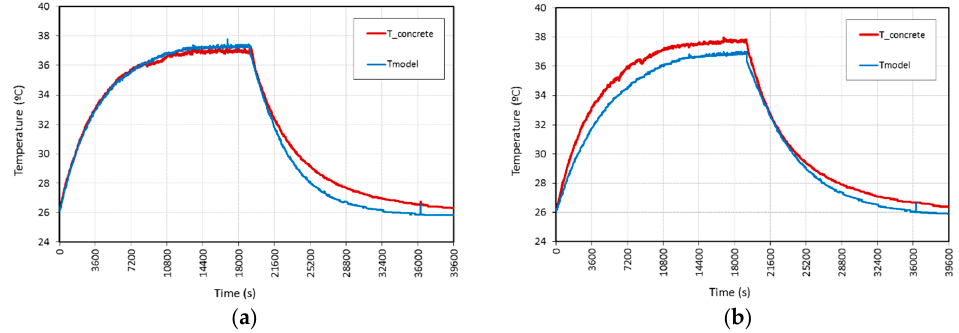
Figure 6. Temperature comparison between experimental results and mathematical model for L.C.